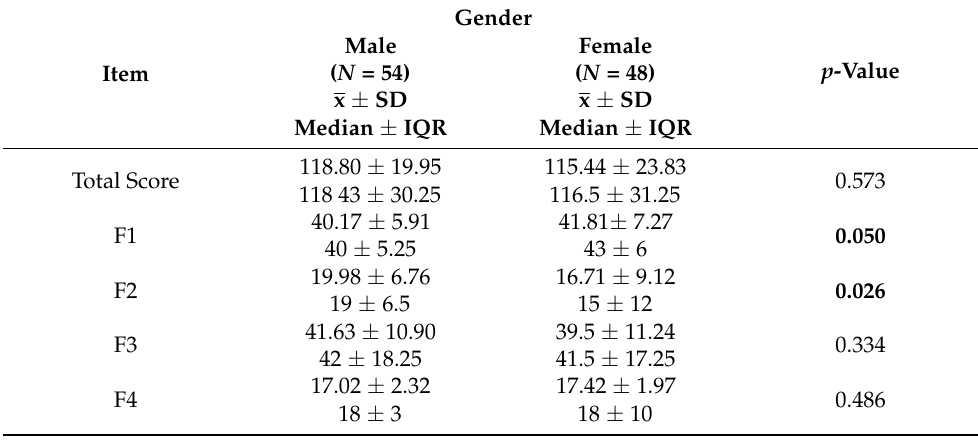
Table 6. Comparison by gender for the total score, each factor, and each item in the